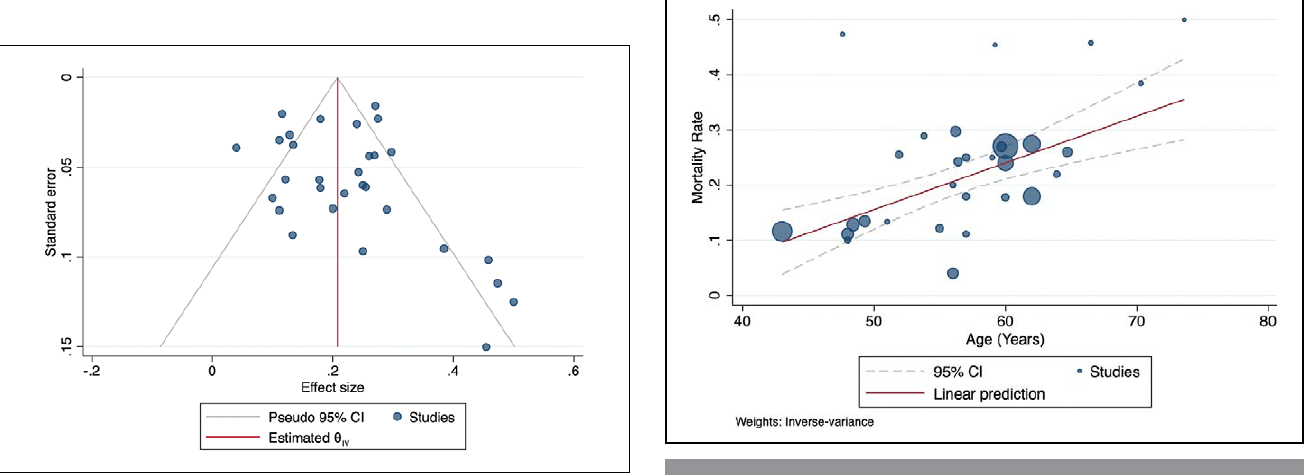
Figure 7. Meta-regression analysis on mortality rate of kidney transplant recipients with COVID-19 infection using age as